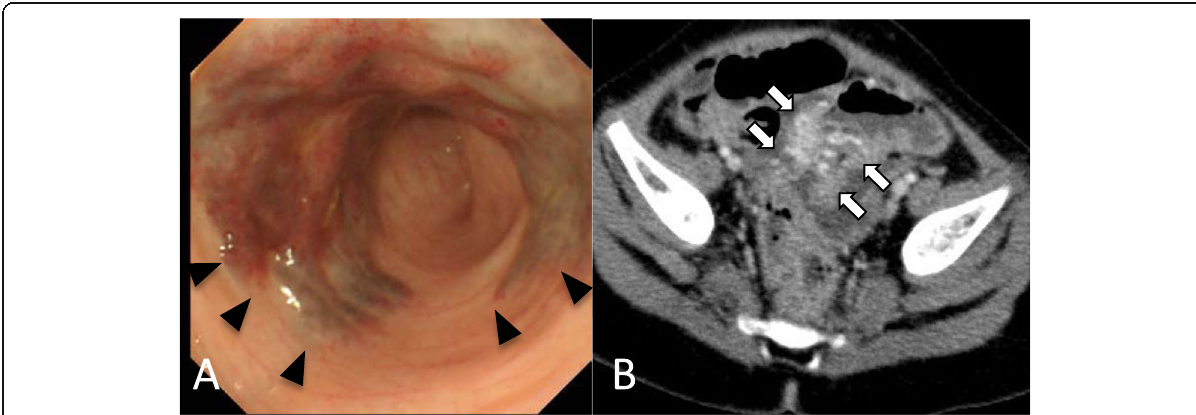
Fig. 1 Imaging of the arteriovenous malformation. a Colonoscopic view showing the protruding lesion, which was suggestive of a submucosal vascular abnormality. b Contrast-enhanced computed tomography image showing dilation of the blood vessels in the lesion, but no hypertrophied feeding artery or draining